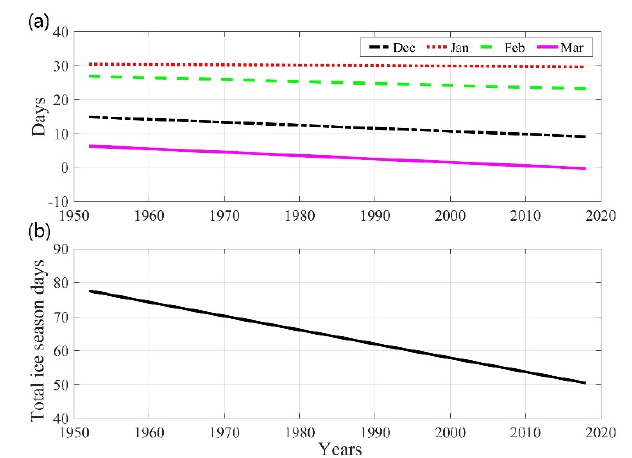
Figure 7. ( a ) Number of ice-days for each month. ( b ) Number of ice-days for entire winter season.